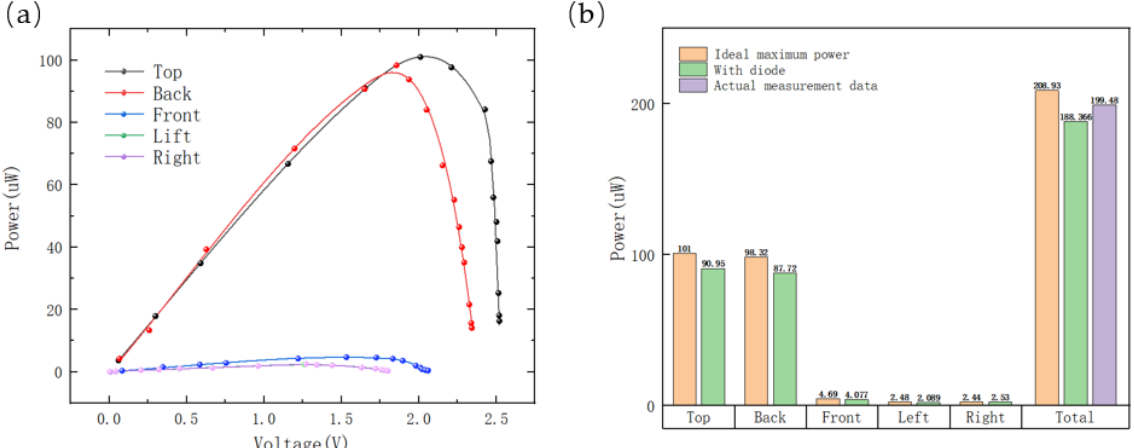
Figure 10. ( a ) P-V curve of a single-sided PV; ( b ) comparison of the output power of the scheme proposed in this paper with that of the traditional scheme.